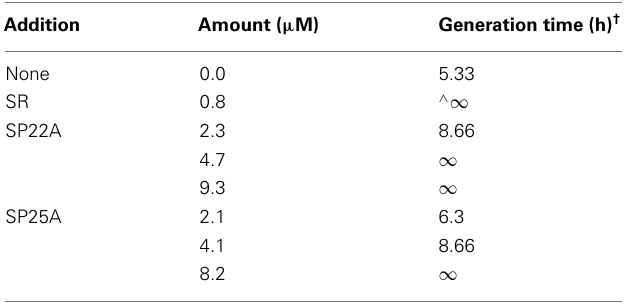
Table 2 | Effects of SRE, SP22A, and SP25A on batch culture growth of S. cerevisiae strain KZ-IC.